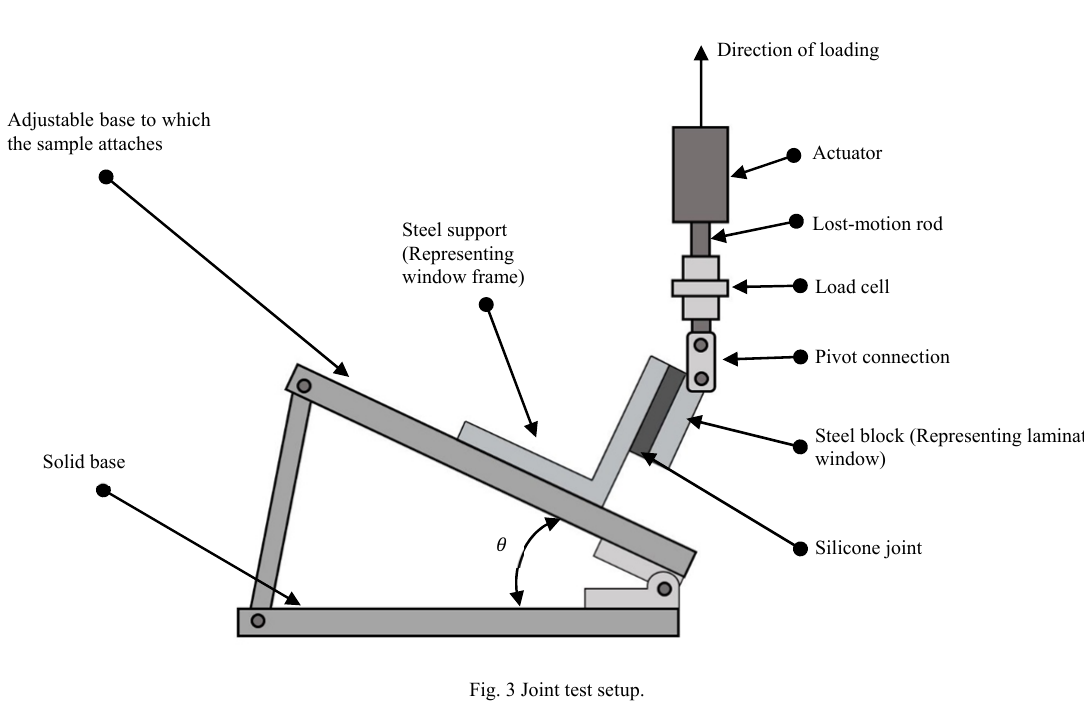
Fig. 2 Joint sample specifications.